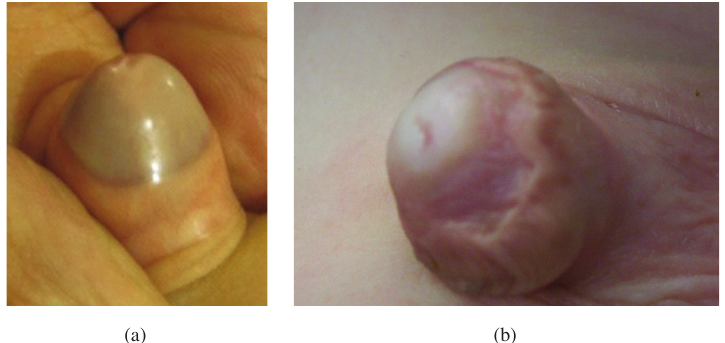
FIGURE 7: Penile adhesions (a) between the shaft skin and the glans can be manually separated while penile skin bridges (b) cannot be manually separated and need to be excised—skin bridge.